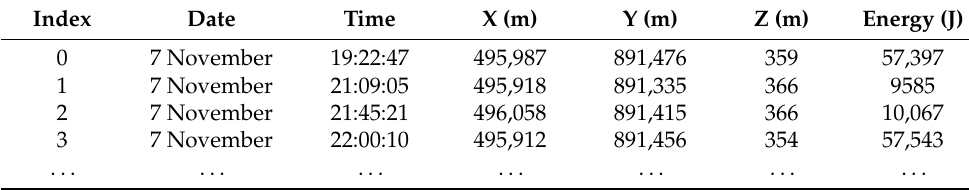
Table 1. Records in microseism monitoring